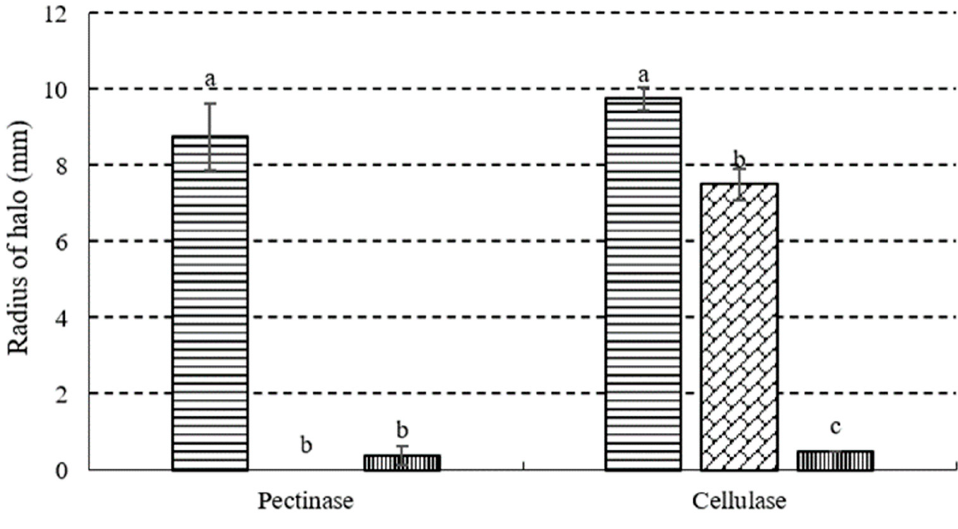
Figure 4. Pectinase and cellulase activities of D. zeae NCPPB 3531, P. polymyxa strain SF05 and B. subtilis BS0512. Different lowercase letters denote significant differences ( p < 0.05).